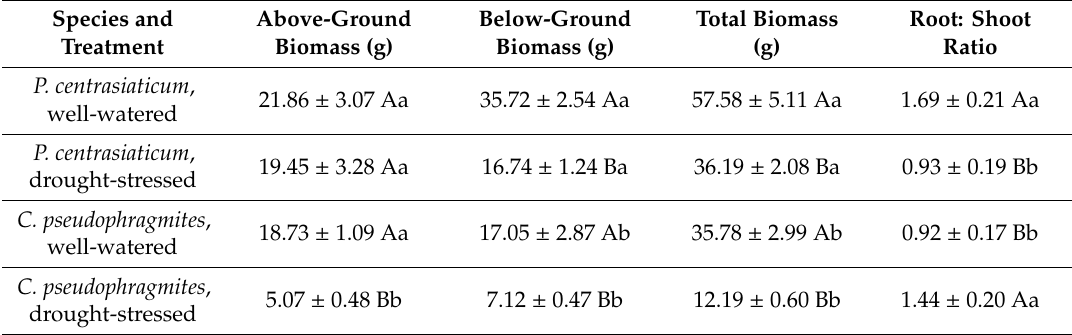
Table 1. Biomass and root: shoot ratio for P. centrasiaticum and C. pseudophragmites. Values are means ± SE ( n =